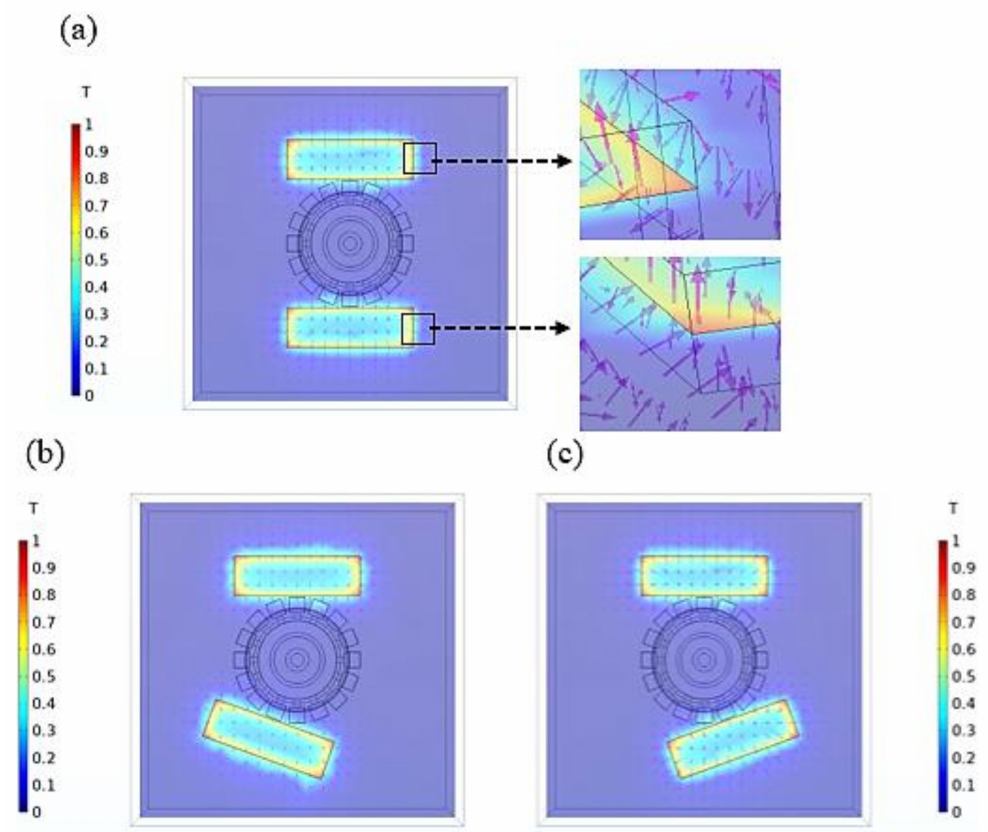
Figure 12. Simulation results of different models of a thermomagnetic heat engine, where two permanent magnets are placed at different positions to each other: ( a ) 180 ◦ , ( b ) 160 ◦ , and ( c ) 200 ◦ .